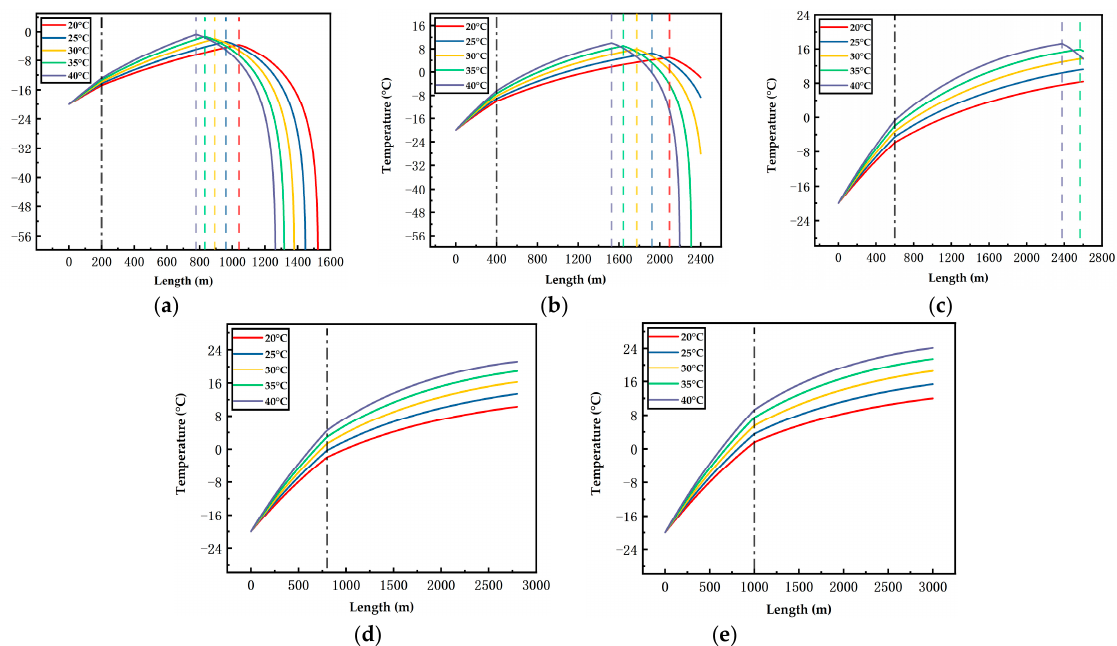
Figure 6. Variation of the on-way temperature with the length at 1 m/s airflow velocity, different ambient temperatures and depths (( a ) 200 m; ( b ) 400 m; ( c ) 600 m; ( d ) 800 m; ( e ) 1000 m). The black dotted line indicates the connection between the vertical pipe and the underground pipe; The dotted lines in other colors represent gasification points.